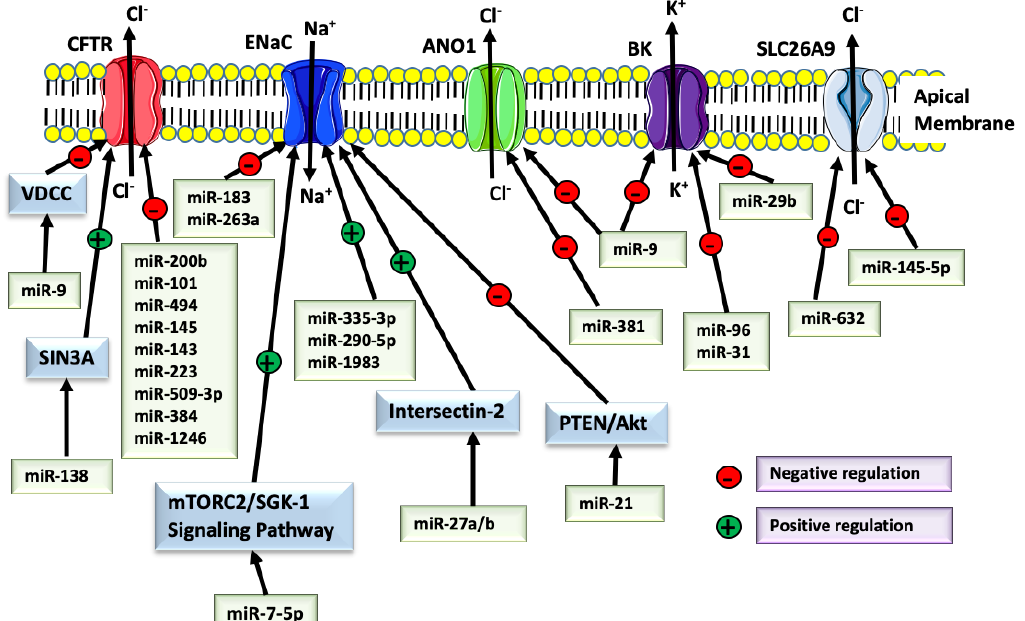
Figure 2. Summary of the ion transport regulation by miRNAs in human bronchial epithelial cells. miRNAs may regulate ion transport by directly targeting the channels’ mRNA or indirectly by modulating the expression of regulatory proteins and signaling pathways that control the channels’ function. CFTR: cystic fibrosis transmembrane conductance regulator; ENaC: Epithelial Na+ Channel;